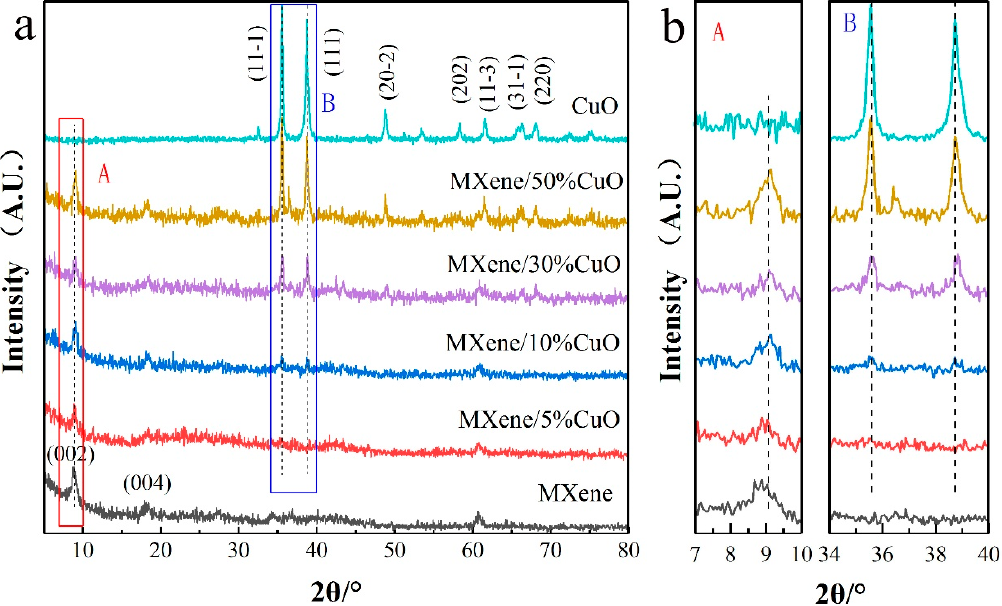
Figure 1. Illustration of mixing-calcination strategy for the facile construction of a MXene/CuO nanocomposite.